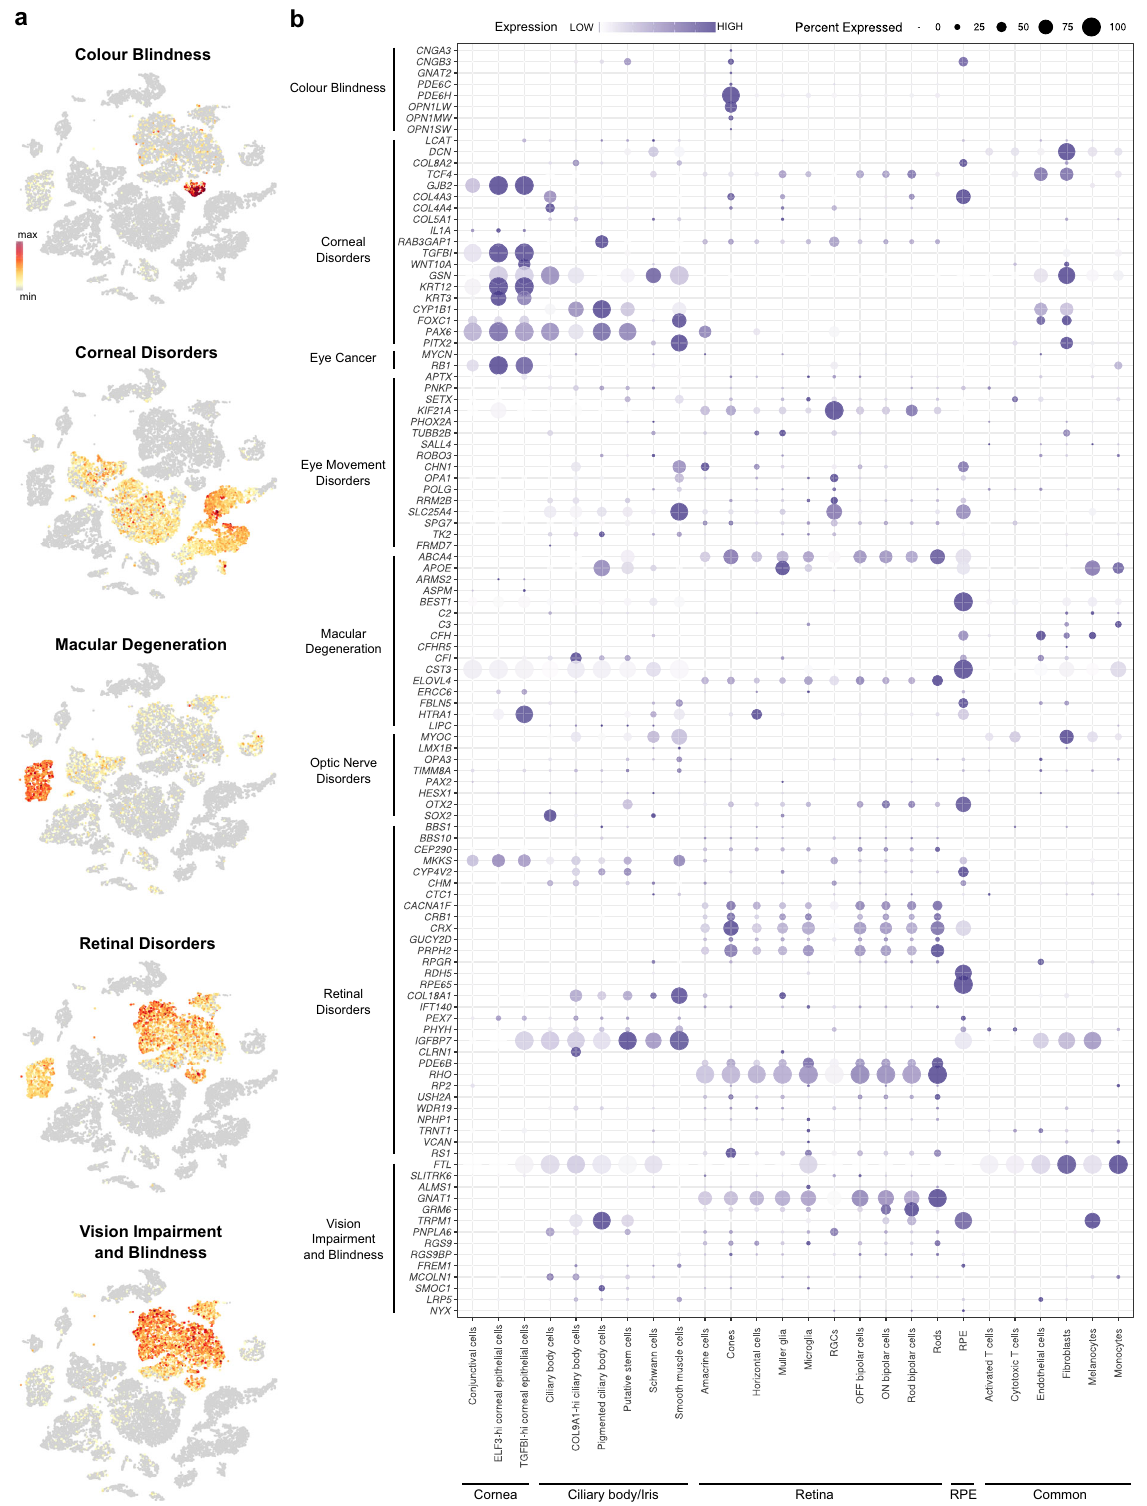
Fig. 5 Creating a disease map for the human eye. a Human eye disorder-associated gene-set scores visualised on a tSNE plot. Scaled scores for each cell were colour-coded. b Bubble plot showing expression of genes involved in different eye disorders across cell types of